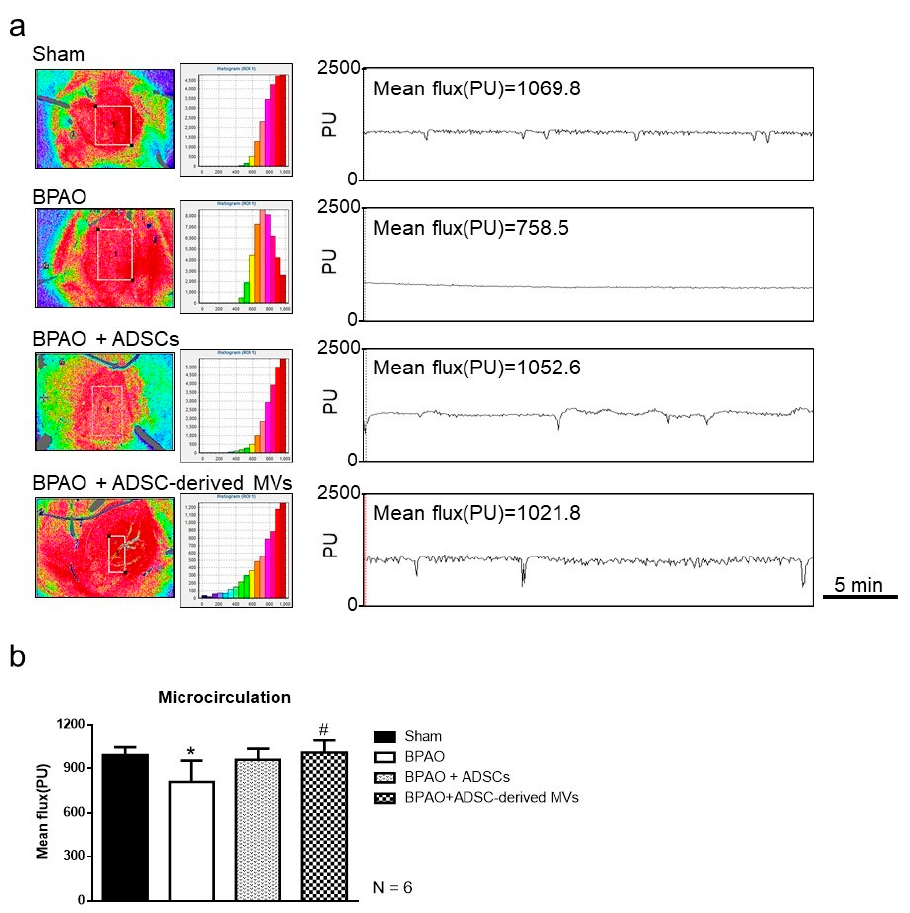
Figure 2. Microcirculation patterns on speckle contrast imaging study in separated group. In the top panel, ( a ) showed the real-time measurements of bladder microcirculation with laser speckle contrast imaging. In the bottom panel, ( b ) demonstrated a significant redistribution of color-scale of the bladder body associated with a decline in high-flow areas (red) and an increase in low-flow areas in BPAO group compared to sham group (* p < 0.05). The BPAO + ADSC-derived MVs group had significant mitigation of the reduced microcirculation following BPAO ( # p < 0.05). The BPAO + ADSCs group had trend of reversing the reduced microcirculation following BPAO ( p > 0.05). Table 1. Detailed data of behavior parameters among groups on metabolic cage study. Data are presented as mean ± standard deviation; the 95% confidence intervals are shown in brackets. * p < 0.05 vs. sham group by two-tailed